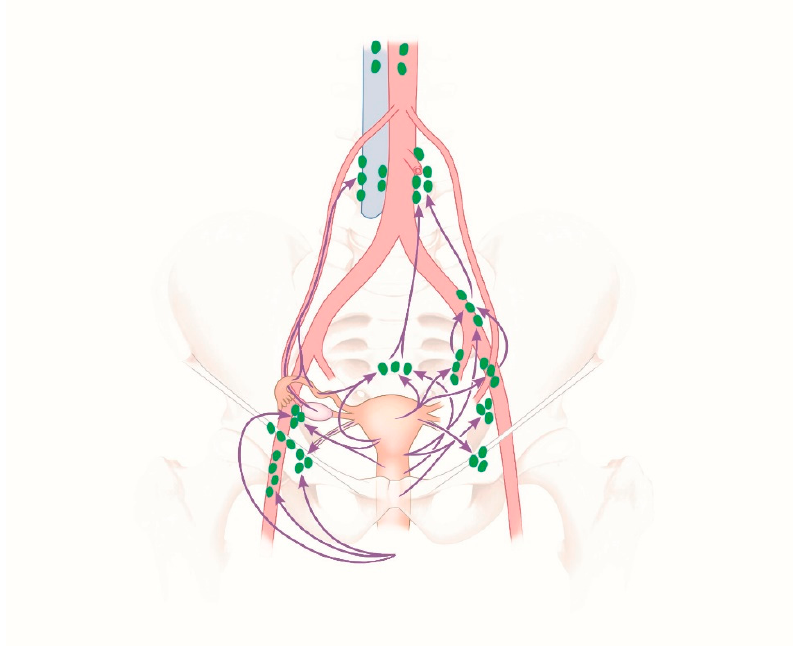
Figure 3. Lymphatic drainage and regional lymph nodes of the female genital organs. The individual lymph node groups are marked green; violet arrows indicate the lymphatic flow from the respective anatomical region.